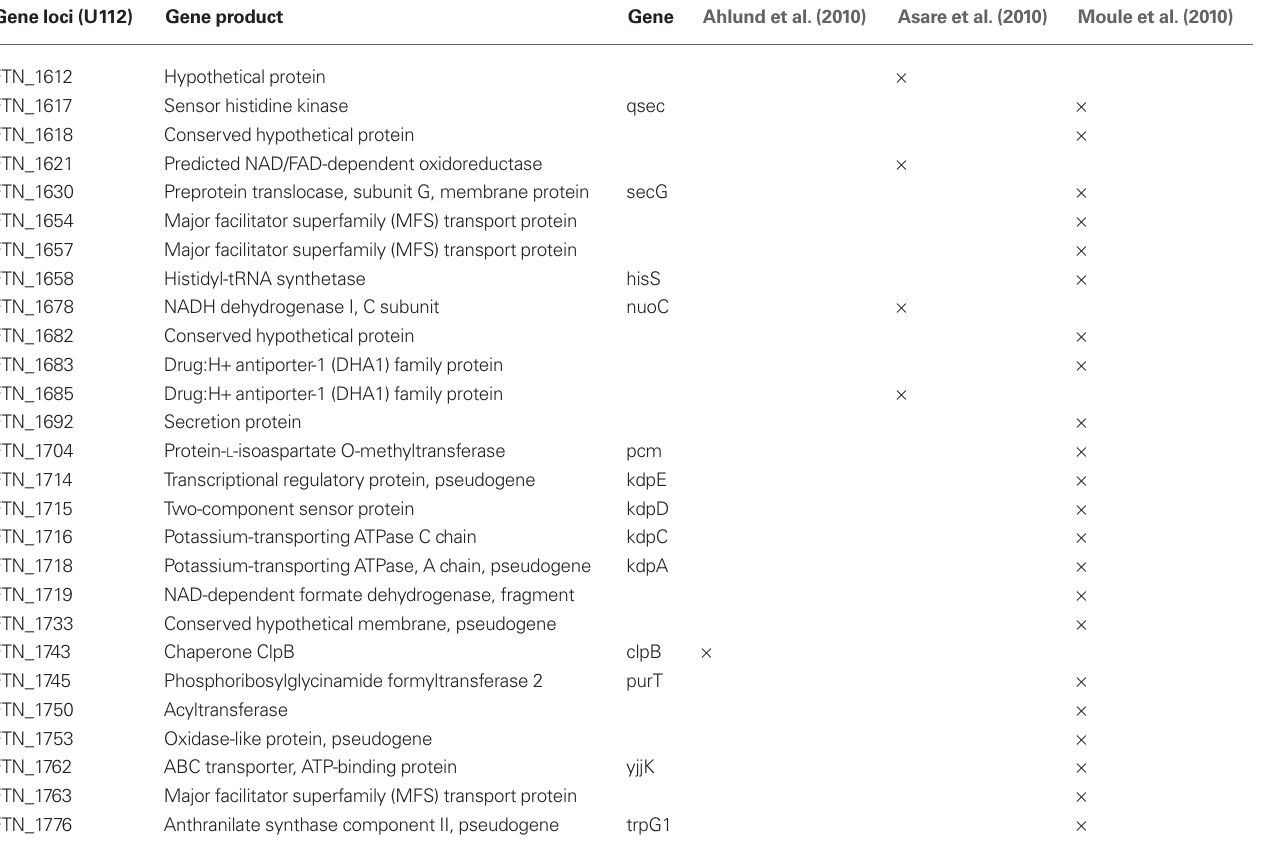
( Table 2 ): the Ras/Rho guanyl-nucleotide exchange factor